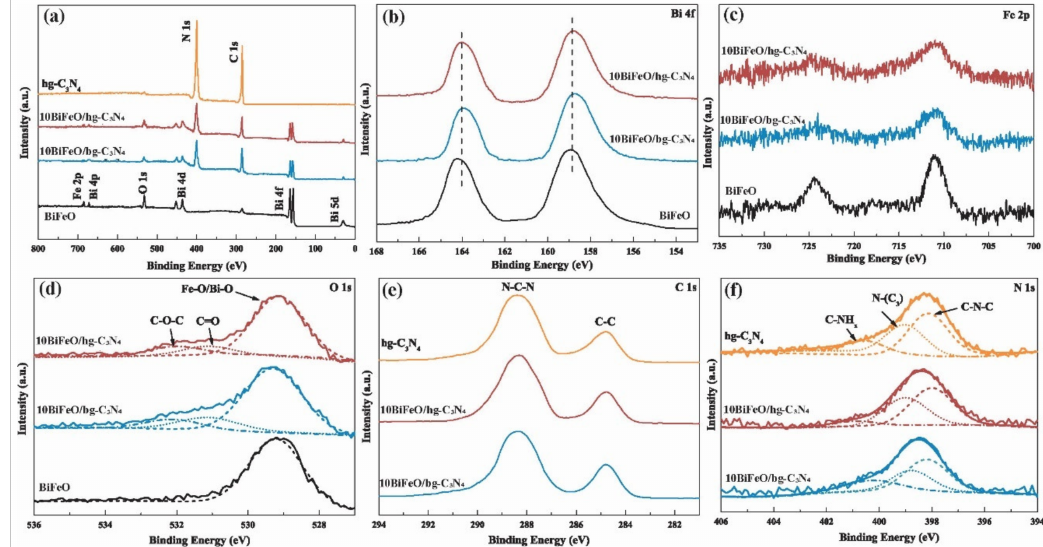
Figure 4. XPS spectra profiles ( a ) survey of hg-C 3 N 4 , 10BiFeO/hg-C 3 N 4 , 10BiFeO/bg-C 3 N 4 , and BiFeO; ( b ) Bi 4f of 10BiFeO/hg-C 3 N 4 , 10BiFeO/bg-C 3 N 4 , and BiFeO; ( c ) Fe 2p of 10BiFeO/hg-C 3 N 4 , 10BiFeO/bg-C 3 N 4 , and BiFeO; ( d ) O 1s of 10BiFeO/hg-C 3 N 4 , 10BiFeO/bg-C 3 N 4 , and BiFeO; ( e ) C 1s of hg-C 3 N 4 , 10BiFeO/hg-C 3 N 4 , and 10BiFeO/bg-C 3 N 4 ; ( f ) N 1s of hg-C 3 N 4 , 10BiFeO/hg-C 3 N 4 , and 10BiFeO/bg-C 3 N 4 .